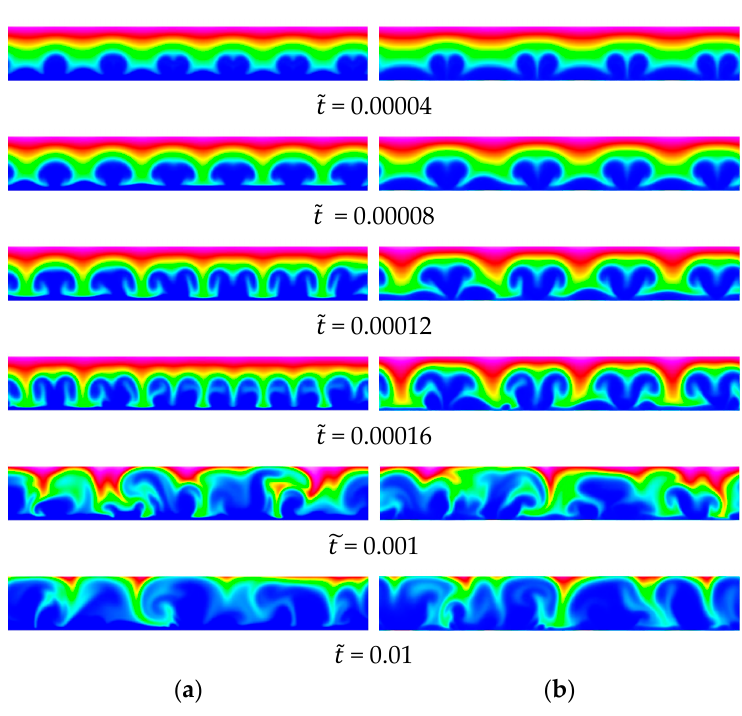
Figure 15. Baseline 2-D case, 𝑉(cid:3560) = 120. Wavy membrane with 𝐴 = 0.01 μm and ( a ) 𝜆 = 10 μm and ( b ) 𝜆 = 15 μm . Anion concentration.